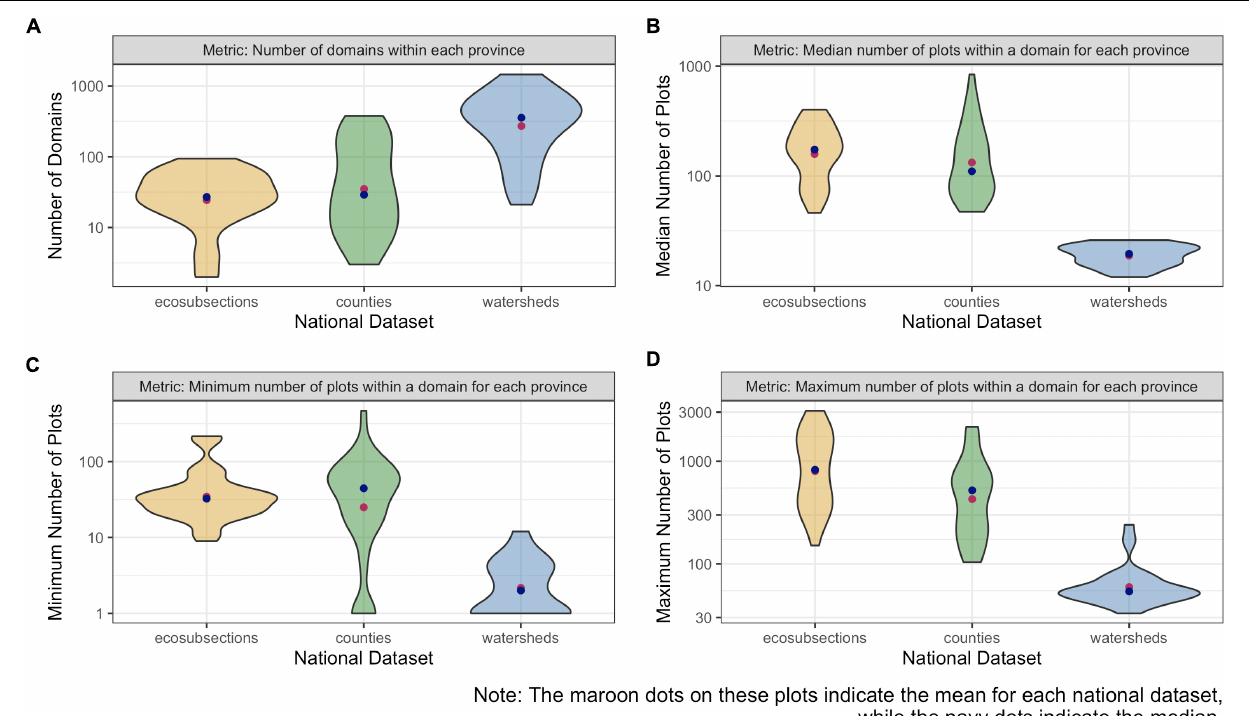
FIGURE 4 | Violin plots reflecting the distribution, by national dataset, of (A) number of domains within the provinces, as well as (B) median, (C) minimum, and (D) maximum number of plots per domain within the provinces. The maroon dots on these plots indicate the mean for each national dataset, while the navy dots indicate the median. The color of the violin plot indicates the national dataset it represents: yellow for ecosubsections, green for counties, and blue for watersheds. Note that the y -axis is spaced on a log10